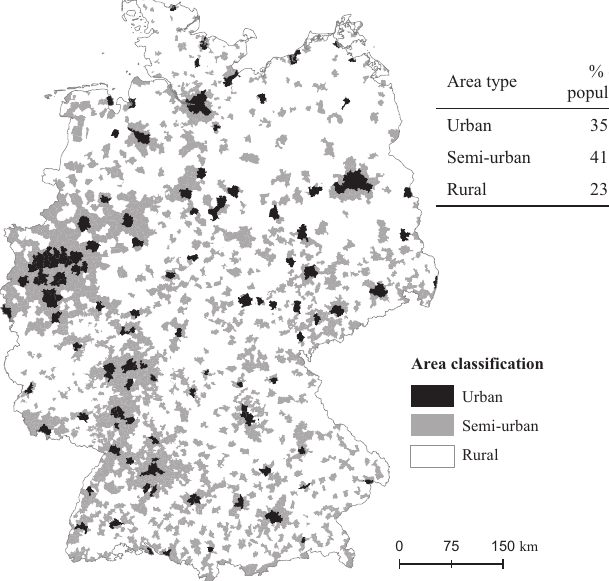
Figure 2. Area classification for Germany in 2013 according to the approach of EUROSTAT